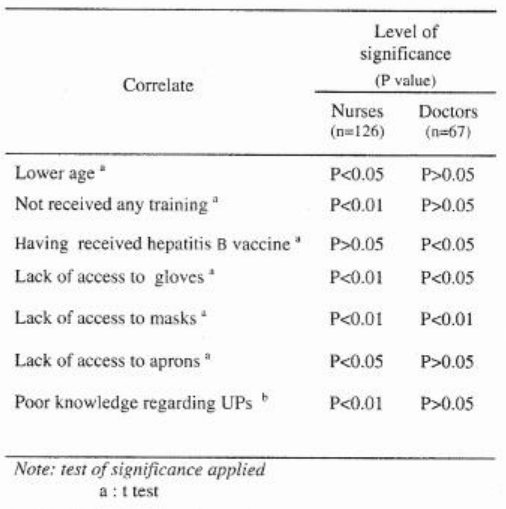
Table 3. Factors associated with poor compliance with universal precautions among nurses and